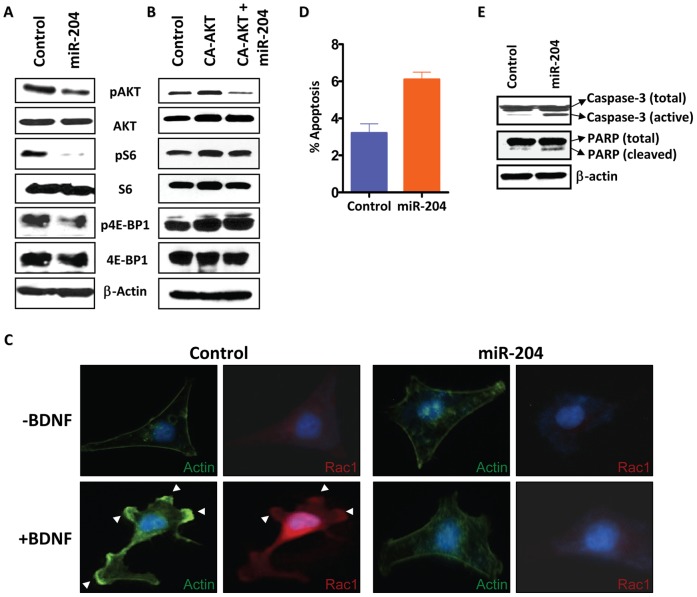
MiR-204 inhibits tumor cell migration and invasion by altering AKT/mTOR/Rac1 signaling.A, miR-204 suppresses activation of AKT and mTOR signaling. HEK-293 cells transfected with miR-204 were grown in serum-free conditions and subjected to western blot analysis using anti-phospho-Ser473-AKT (1∶1000), anti-total-AKT (1∶1000), anti-phospho-Ser235/236-S6 (1∶1000), anti-total-S6 (1∶1000), anti-phospho-Thr37/46-4E-BP1 (1∶1000) and anti-total-4E-BP1 (1∶1000). β-actin (1∶10,000) was used as a loading control. Gel photographs are representative of three independent experiments. B, HEK-293 cells transfected with constitutively active AKT T308D/S473D mutant (CA-AKT) in the absence and presence of miR-204 were grown in serum free condition and subjected to western blot analysis as descried in A. C, overexpression of miR-204 abolishes BDNF-induced membrane ruffling and Rac1 translocation. HEK-293 cells transfected with miR-204 or miR-185 were grown in serum-free conditions and treated with or without BDNF (100 ng/mL) for 10 min and stained with Rac1 antibody (red) and FITC-phalloidin (green). Arrows indicate membrane-ruffling regions. D, miR-204 increases the sensitivity of HEK-293 cells to apoptosis as determined by Annexin V/PI staining using the FITC-Annexin V Apoptosis Detection Kit. The percentage cell population shown is the mean±SEM of three independent experiments. E, western blot analysis of HEK-293 cells transfected with miR-204 using anti-caspase-3 (1∶500) antibody and anti-PARP (1∶1000) show increased cleavage of caspase-3 and PARP. β-actin (1∶10,000) was used as a loading control. Gel photograph is representative of three independent experiments.